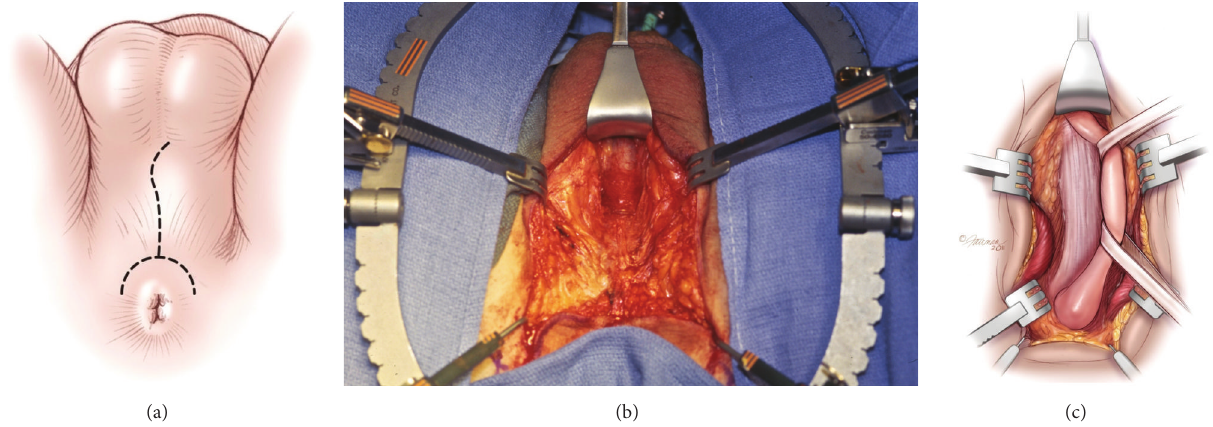
Figure 8: (a) Lambda incision with the patient in the exaggerated lithotomy position. (b) Jordan-Simpson perineal retractor is used to facilitate exposure of the corpus spongiosum. (c) The corpus spongiosum is circumferentially mobilized along the bulbar